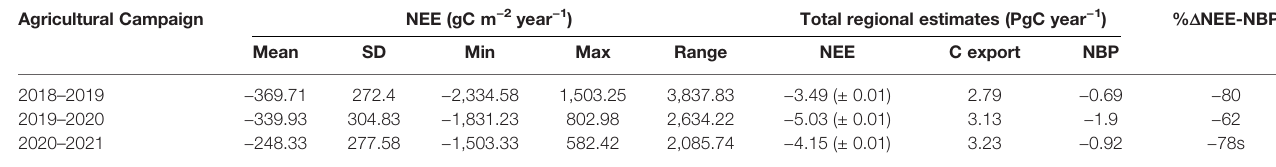
TABLE 4 | Summary statistics for NEE, carbon export, and NBP estimations within the three agricultural campaigns for Inland Pampa croplands with main crops. Agricultural